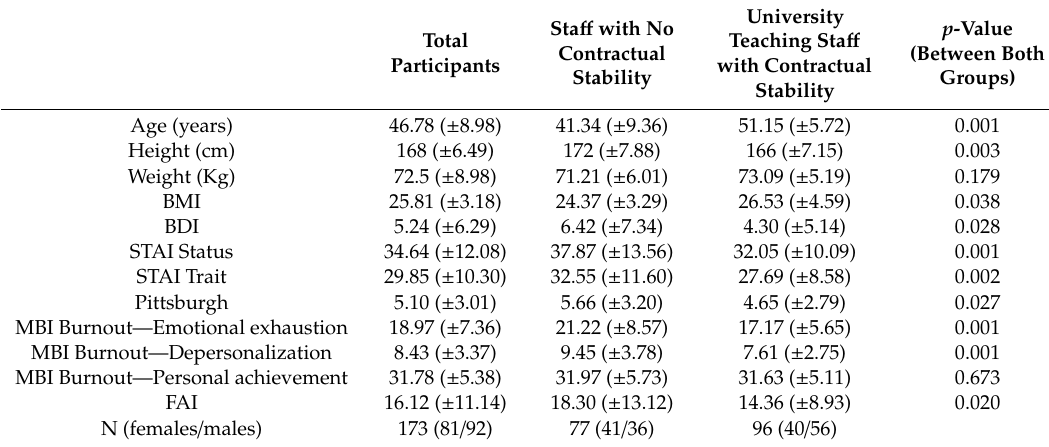
Table 1. Average and standard deviation of university teaching sta ff with no contractual stability and university teaching sta ff with contractual stability.